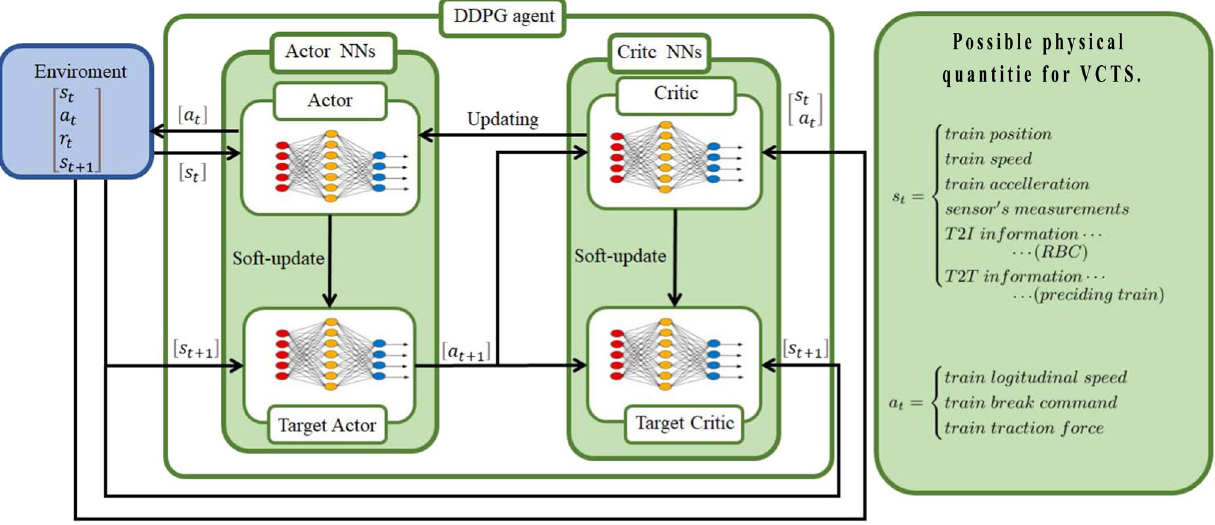
Fig. 2 General architecture of a DDPG-based algorithm ( a t = action space at time t , s t = observation space at time t , r t = reward function at time t . Note that both the action and observation spaces are updated at each time